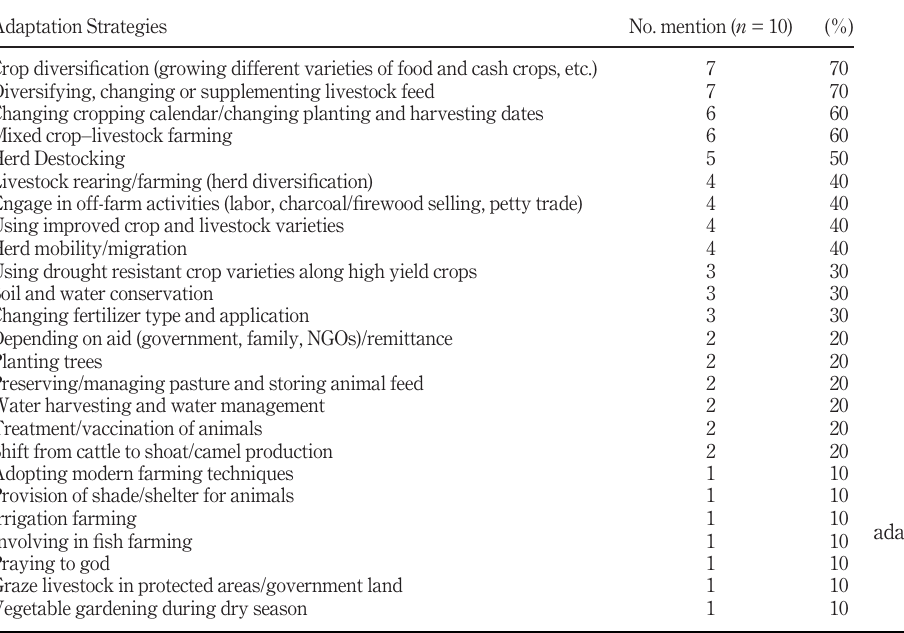
Table V. Climate change adaptation strategies implemented